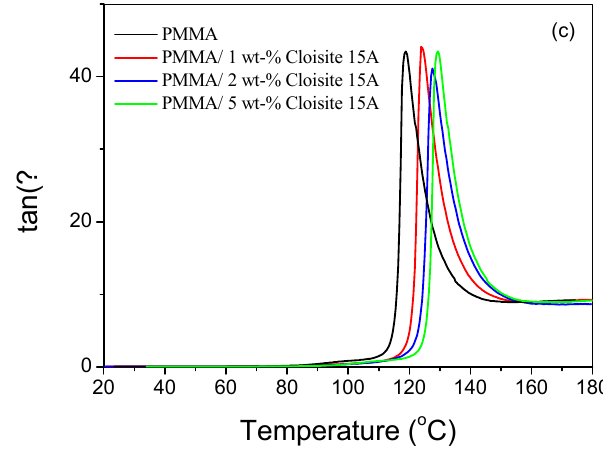
Figure 9. Storage modulus E ′ ( a ), loss modulus E ″ ( b ) and loss tangent tan( δ ) ( c ) as a function of temperature of PMMA nanocomposites with different amount of OMMT clay.